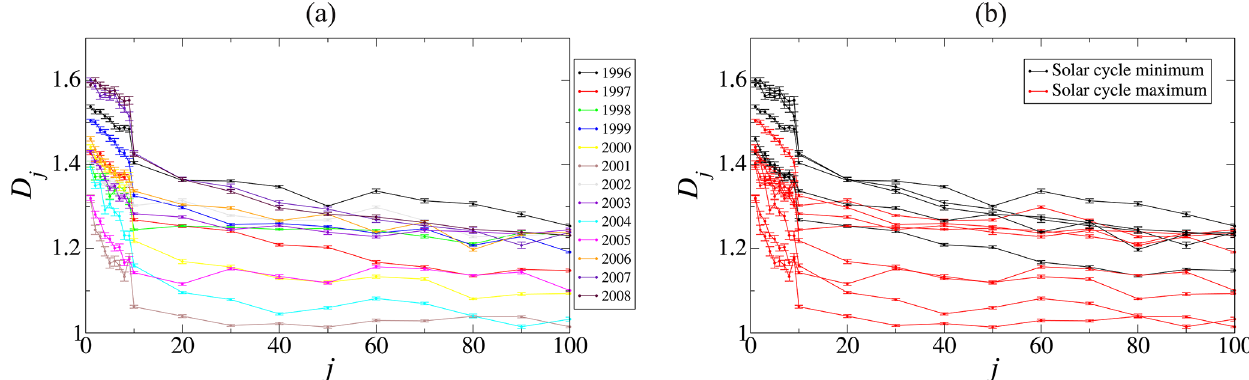
Figure 3. Box-counting dimension of µ(t) for different values of j . (a) Curves for each year of the 23rd solar cycle. (b) Curves are distinguished for years corresponding to the maximum (black lines: years 1998 to 2005) or minimum (red lines: years 1996, 1997, and 2006 to 2008) of the solar cycle.